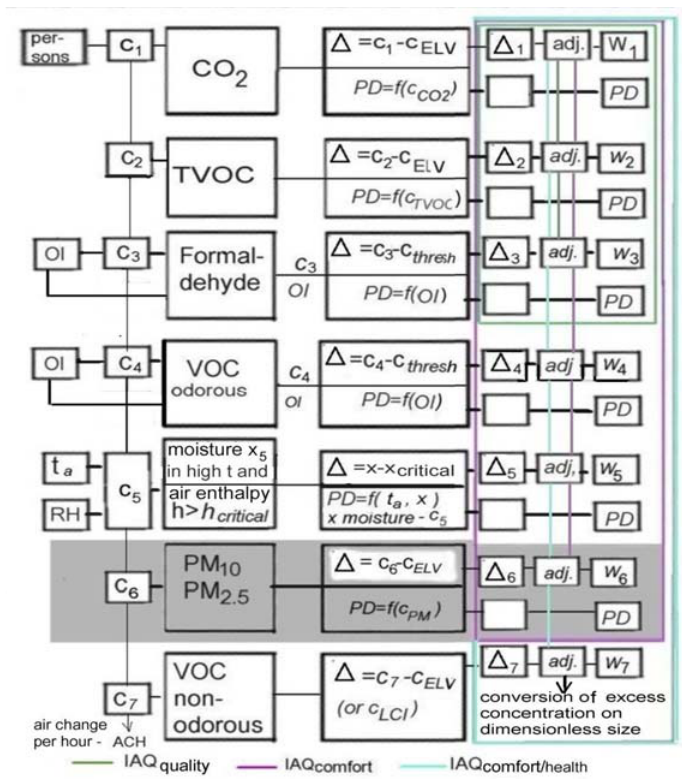
Figure 5.  IAQ index model with weighting scheme. Figure 5. Σ IAQ index model with weighting